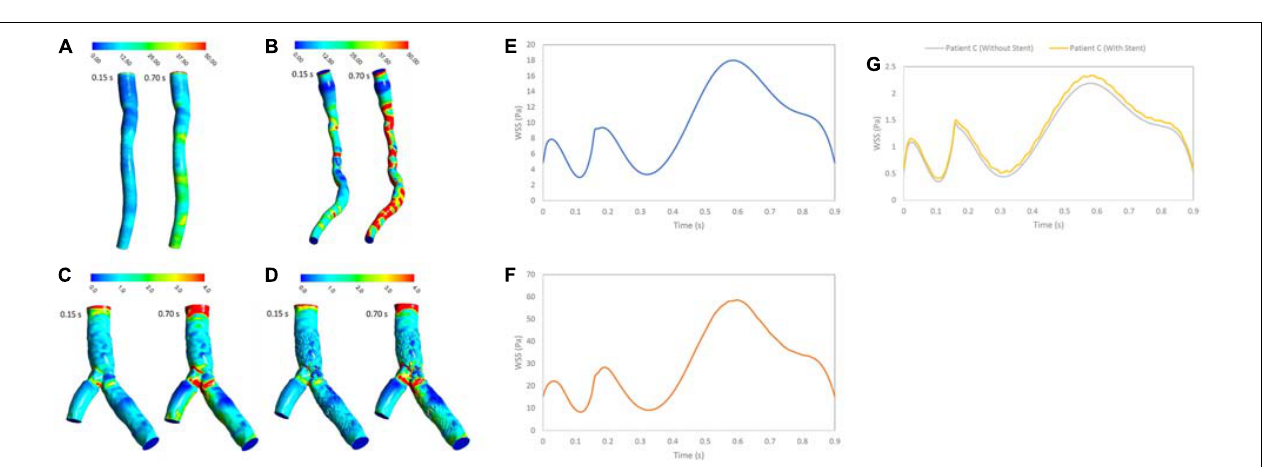
are less marked ( Figure 5A ) while LNH isosurfaces of patient